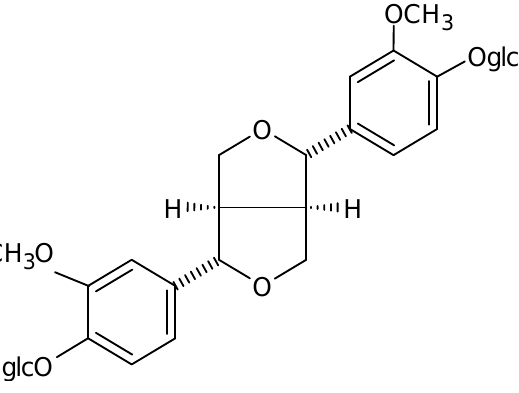
Figure 2. Chemical structure of PDG.